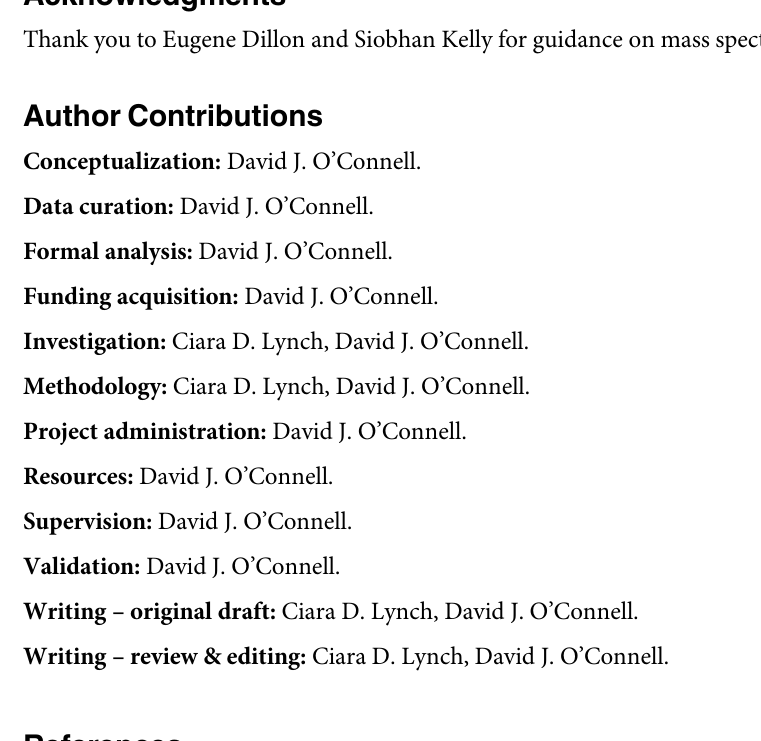
S2 Table. Table of numerical data used to generate growth curves and standard deviations. Completed in triplicate. Corresponds to growth curves generated for Fig